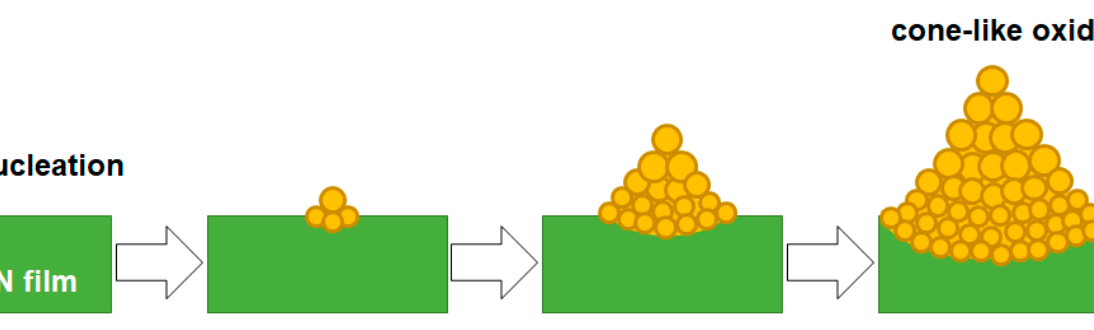
Figure 15. ( a ) and ( b ) XTEM images and SAED patterns of the T1 sample annealed at 600 °C in 1% O 2 –Ar for 8 h.